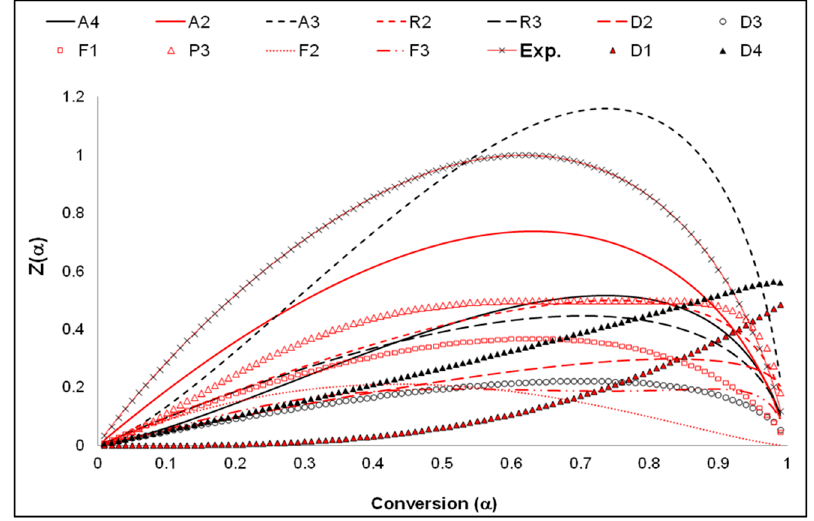
Figure 7. Mechanism determination master curve using Criado method for pre-weathered 50/50 samples.